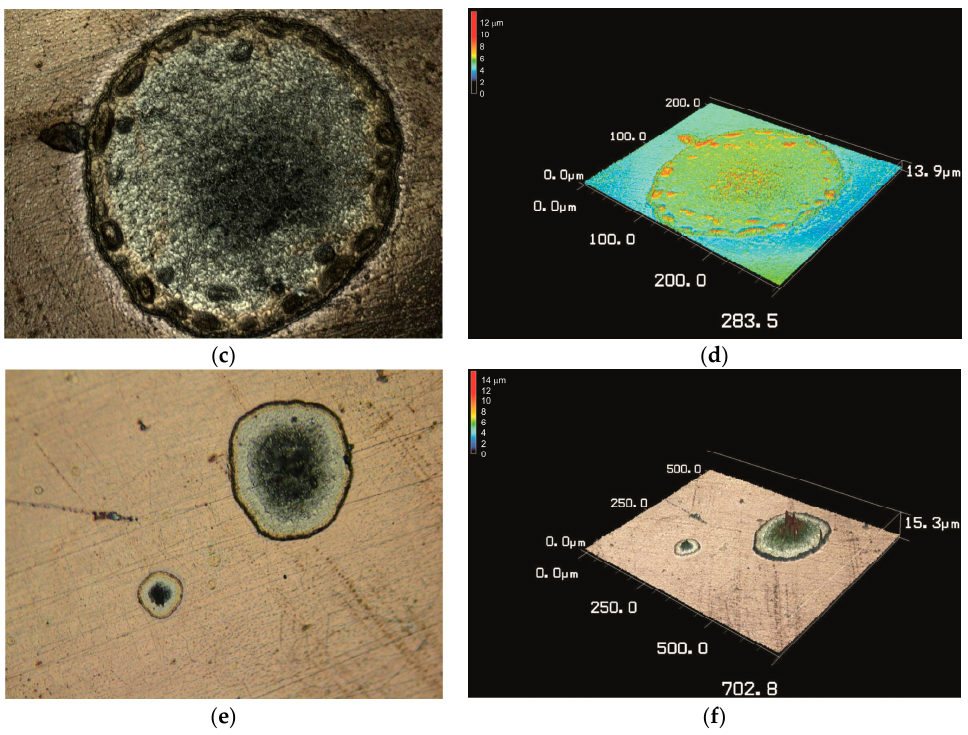
Figure 4. Laser microscope image of the M0 copper surface and the results of their processing: ( a , b ), non-irradiated; ( c – f ), irradiated. The frame size is ( a , b ), 1411.9 × 1000 μ m 2 ; ( c , d ), 283.5 × 200 μ m 2 ; ( e , f ), 702.8 × 500 μ m 2 ; the height is ( b ) 6.7 μ m; ( d ) 13.9 μ m; ( f ) 15.3 μ m.